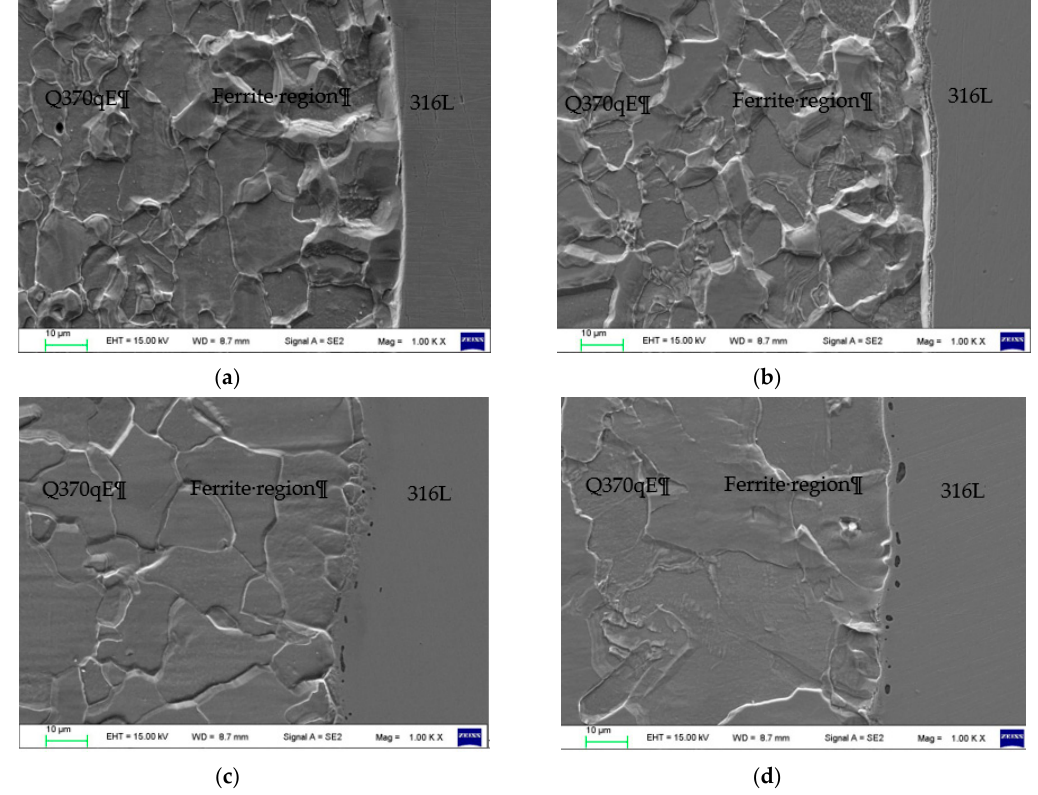
Figure 2. Microstructures of the Q370qE side ( a ) 500 °C; ( b ) 600 °C; ( c ) 800 °C ;( d ) 1000 °C.